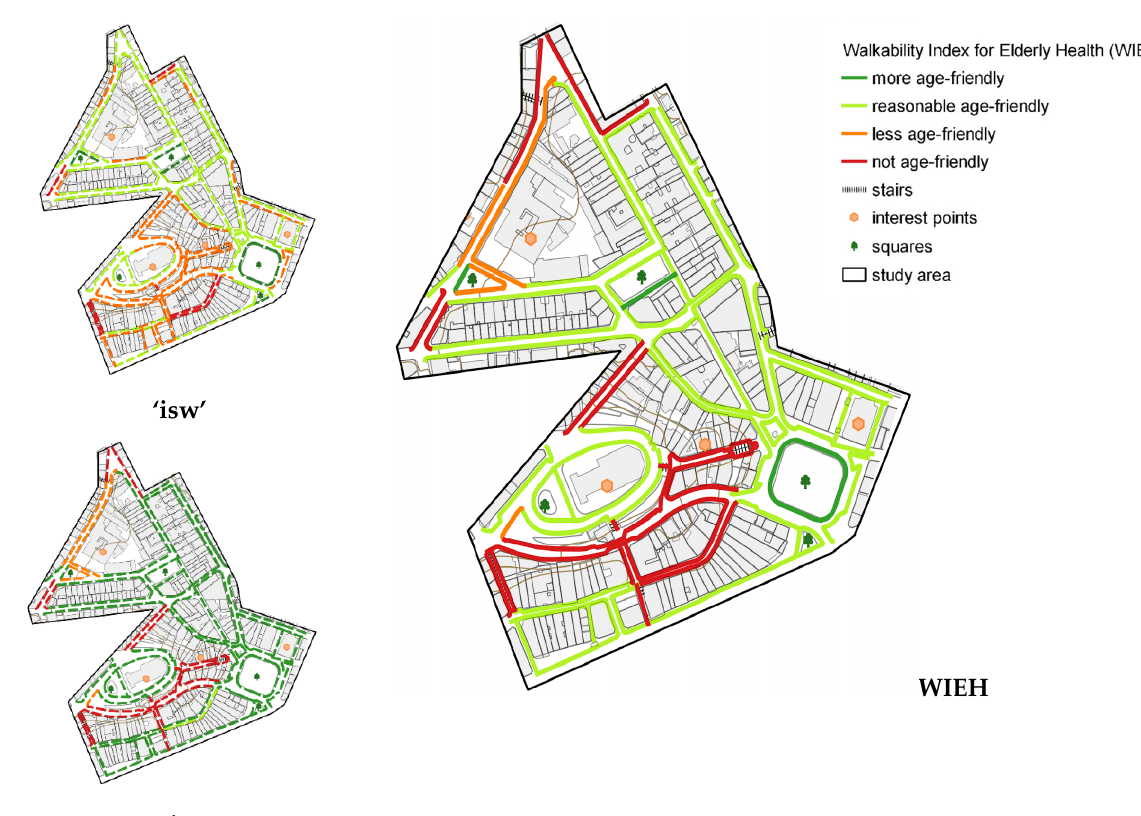
Figure 12. Comparison of ‘isw’, ‘is’, and WIEH ratings. Table 17. Review of the Walkability Index for Elderly Health (WIEH) values and outcome in the study area.